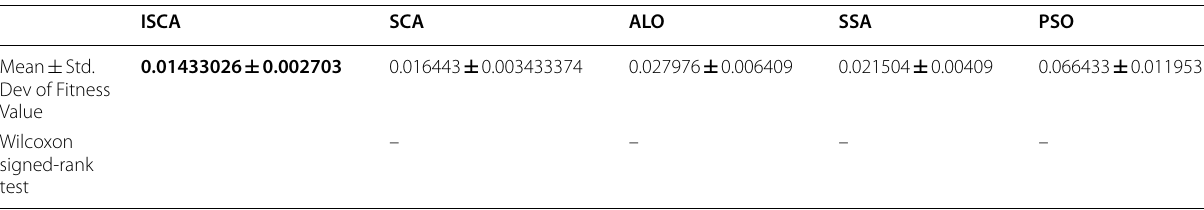
Table 7 Comparison of fitness values and WRST results of the three-area system with SLD of 2% in each area using Different Optimization Techniques (Values in bold shows best value) ISCA SCA ALO SSA PSO Mean Std. ± Dev of